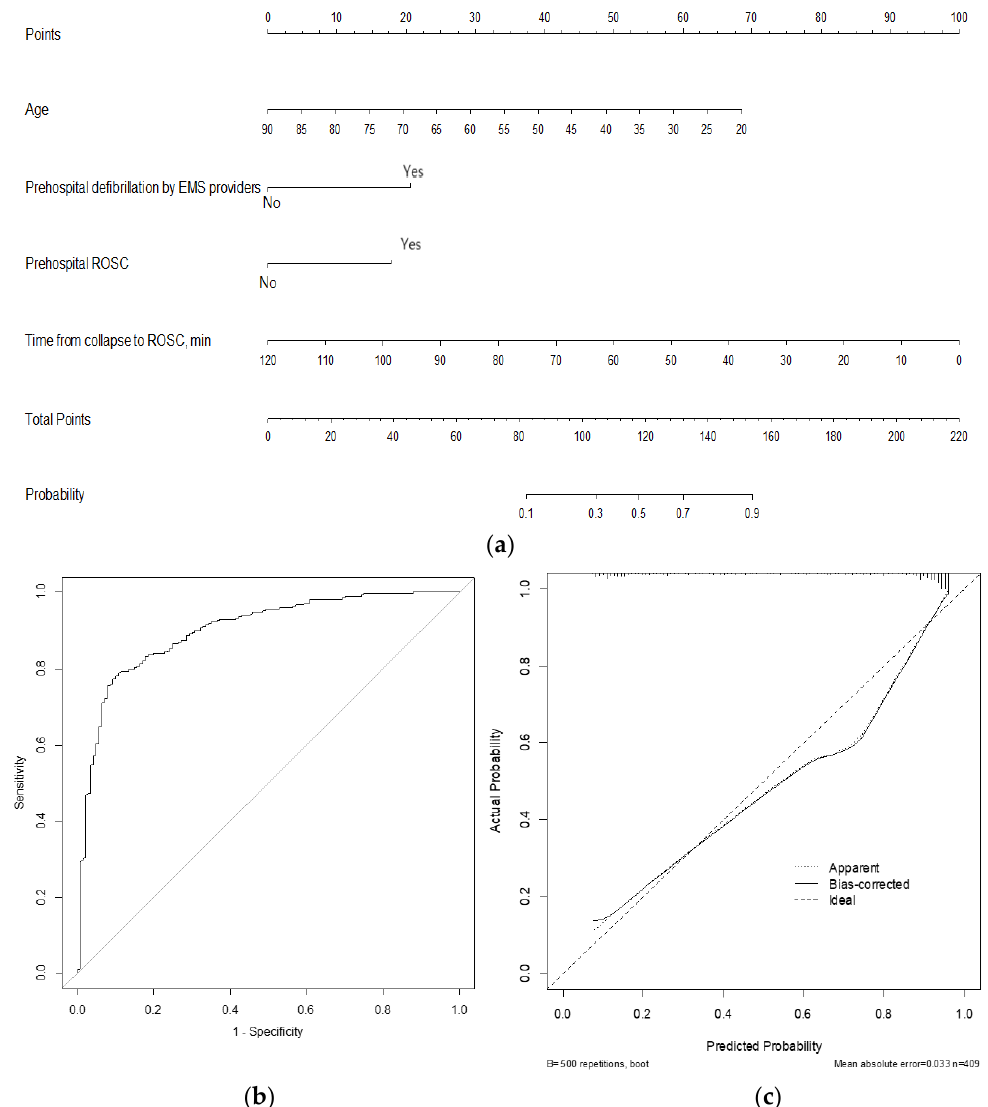
Figure 2. Nomogram for predicting survival discharge. ( a ) The novel nomogram for predicting survival discharge developed using the training data set is shown. ( b ) The discriminative ability of the nomogram is excellent, with an area under the curve of 0.9002 (95% confidence interval: 0.869–0.9315). ( c ) The calibration plot of the prediction model indicates good agreement between the predicted and observed probabilities of survival discharge. Abbreviations: EMS: emergency medical service, ROSC: return of spontaneous circulation.